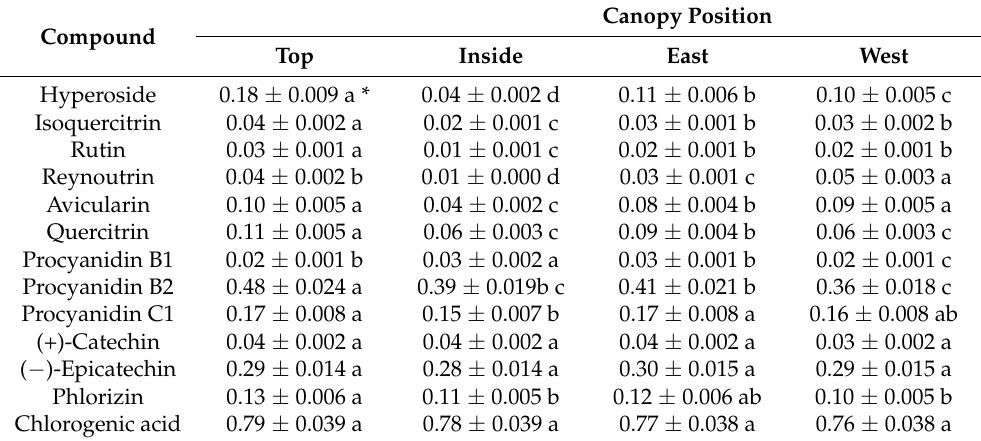
Canopy Position